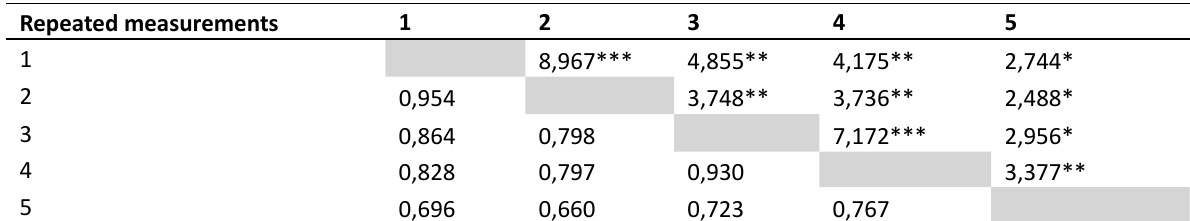
Table 2. Pearson correlation coefficient (left – lower) and corresponding t-Student statistics (right - upper) derived in A−B feet situation Repeated measurements